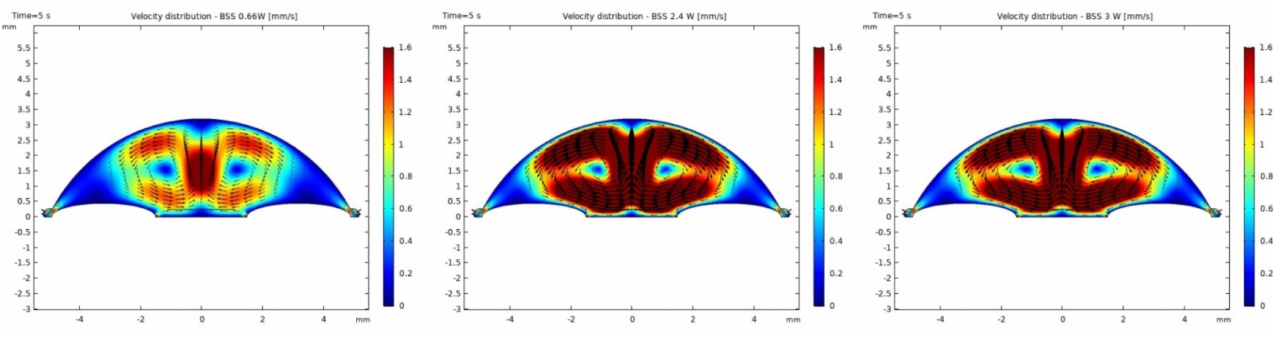
Figure 8. Velocity distributions with BSS after 5 s of 0.66 W, 2.4 W and 3 W impulse.